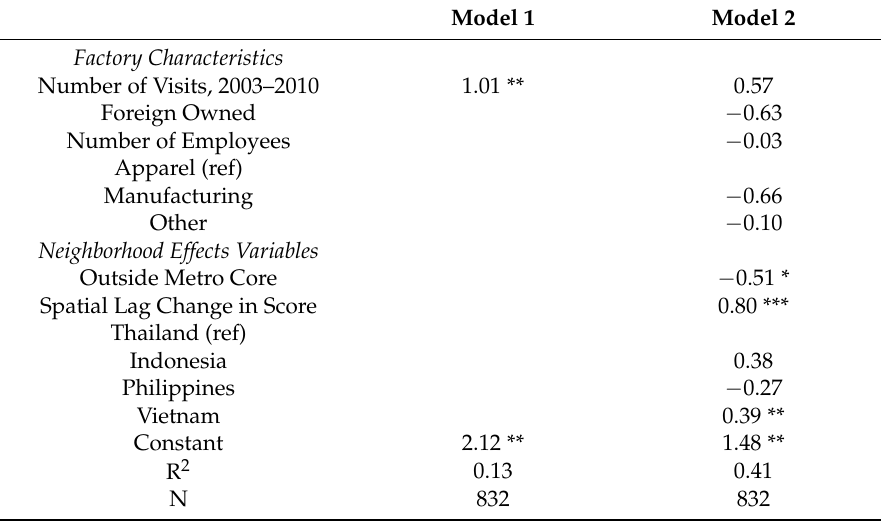
Table 2. Spatially Lagged Regression Results of the Change in Log Audit